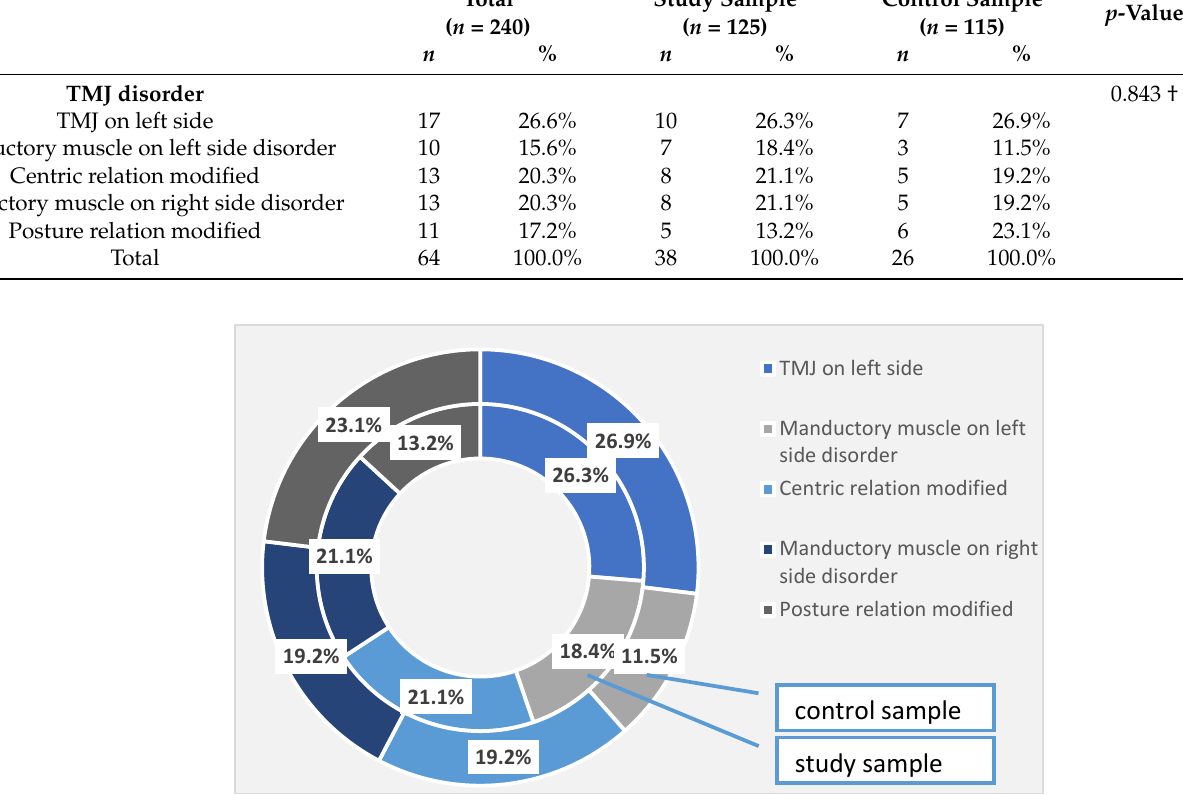
Table 6. The occlusal changes presence by dental mobility and gingival recession in the investi- gated samples.